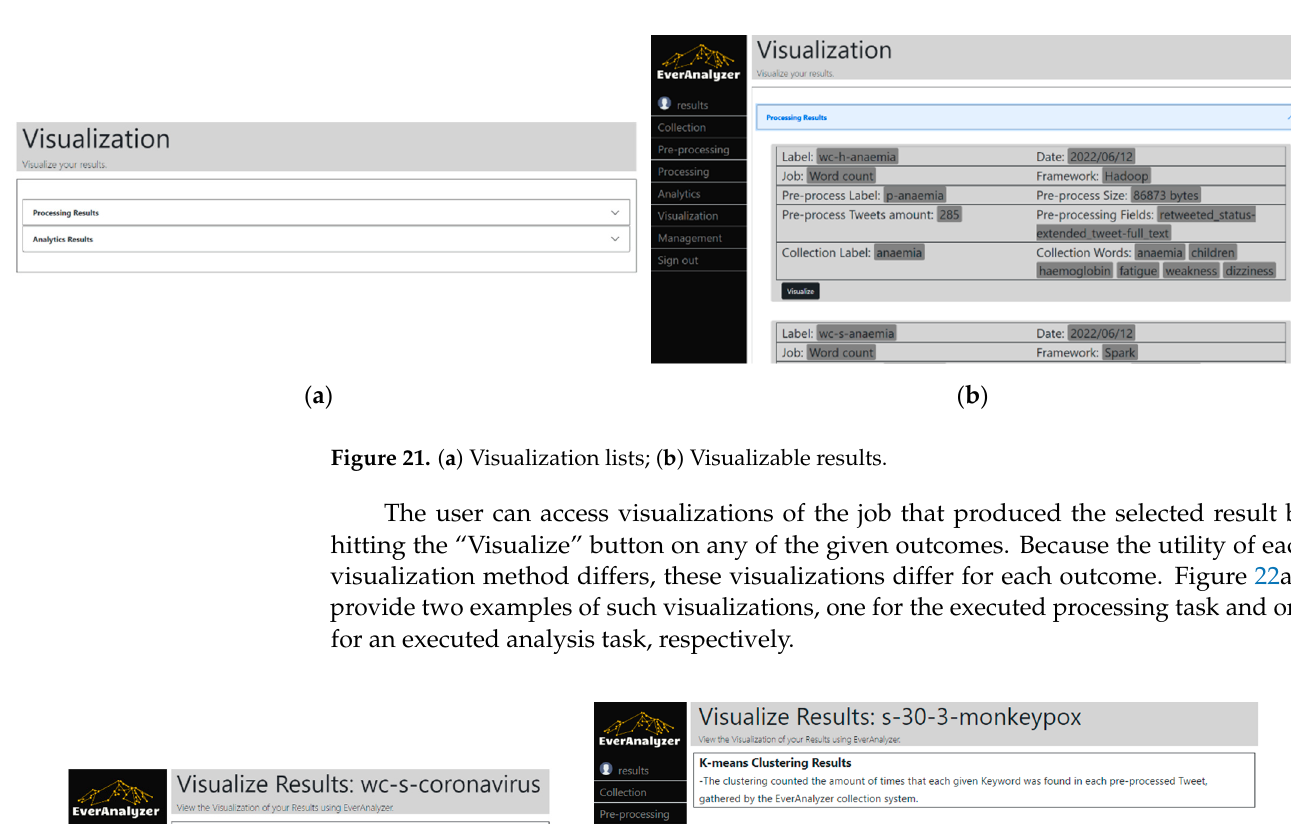
Figure 20. ( a ) Analytics form; ( b ) Analytics proposal.